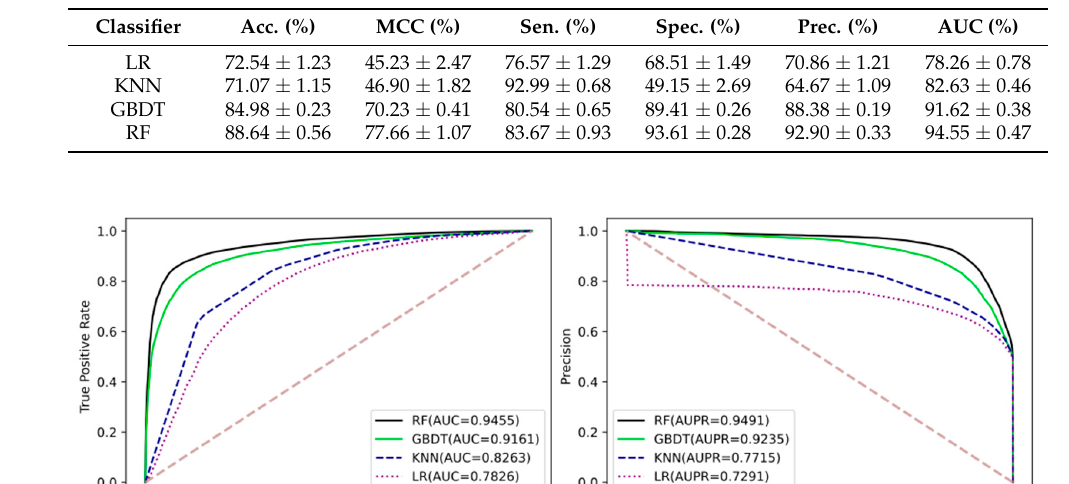
Table 2. Comparison of different machine learning classifier.